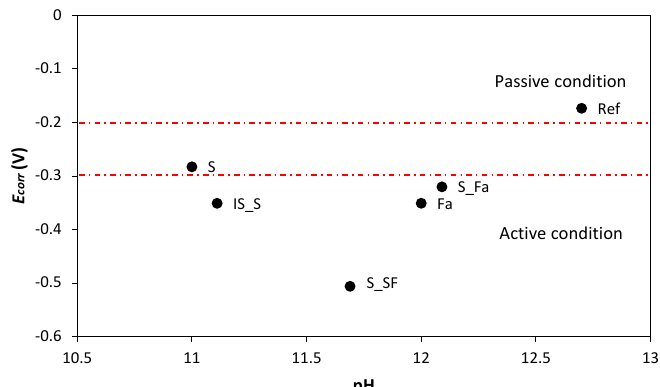
Figure 10. Correlation of the corrosion potential (V) of structural steel and pH of the leaching solution at 28 days of curing. The upper red line indicates > 90% probability of having no corrosion, while the bottom line indicates > 90% probability of having active corrosion, according to the standard ASTM C876 for steel in the OPC system [41].